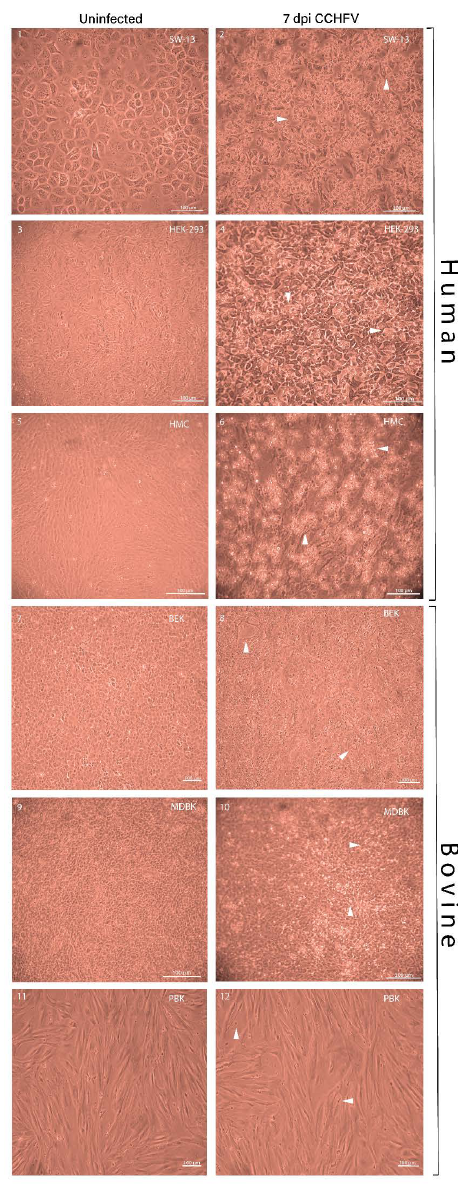
Figure 1. Cytopathic e ff ects in human and bovine kidney cells infected with CCHFV at seven dpi. CPE on primary and immortalized kidney cells were visually scored on one, two, three, five, and seven day-post infection (only day seven shown) by Nikon Eclipse TS-100 inverted light microscope. Seven dpi uninfected cell lines were used as the cell control. Human cells displayed overall cell detachment and cell rounding while bovine cell lines showed localized degeneration and cell deformation. Magnification × 10 (Scale bar: 100 µ m). (1) Uninfected SW-13; (2) infected SW-13; (3) uninfected HEK-293; (4) infected HEK-293; (5) uninfected HMC; (6) infected HMC; (7) uninfected BEK; (8) infected BEK; (9) uninfected MDBK; (10) infected MDBK; (11) uninfected PBK; (12) infected PBK. Arrowheads in images indicate pathological changes observed in the respective cell